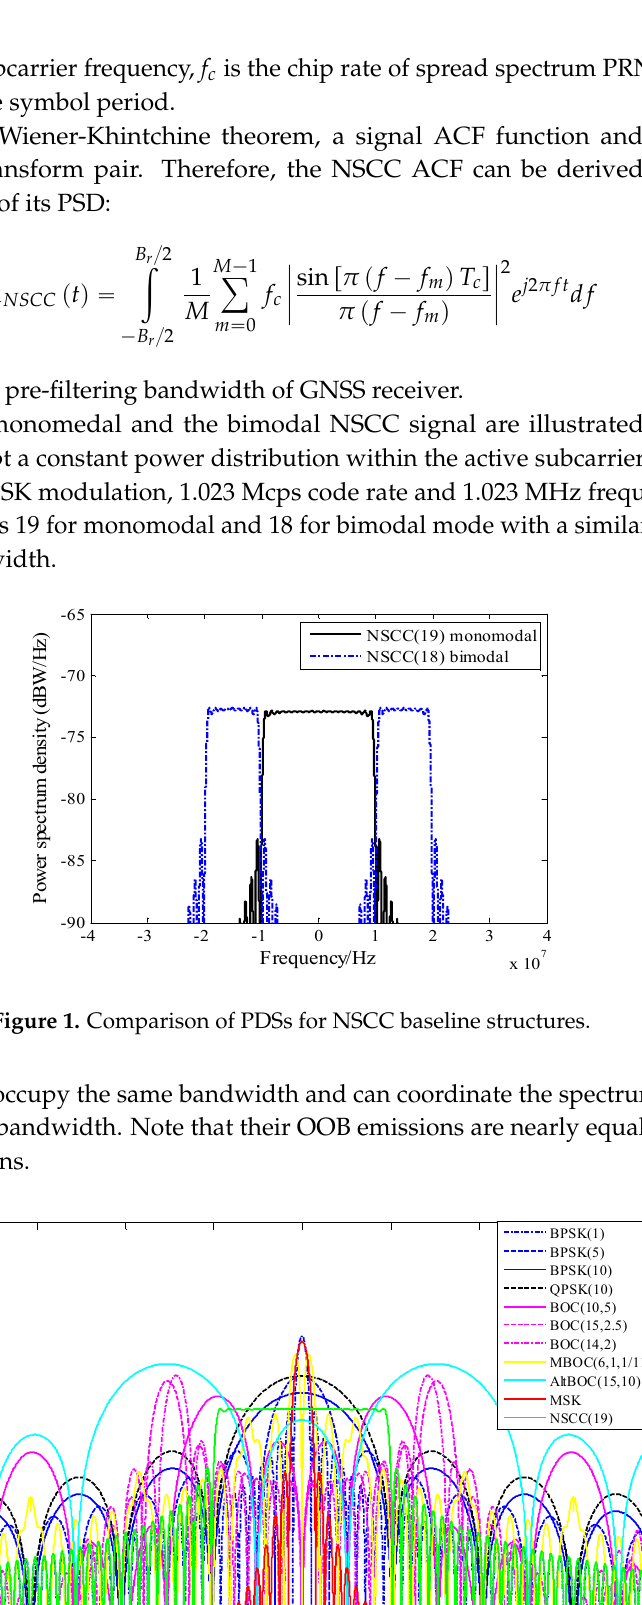
Figure 2. Comparison of PSDs for NSCC and legacy navigation signal modulations.